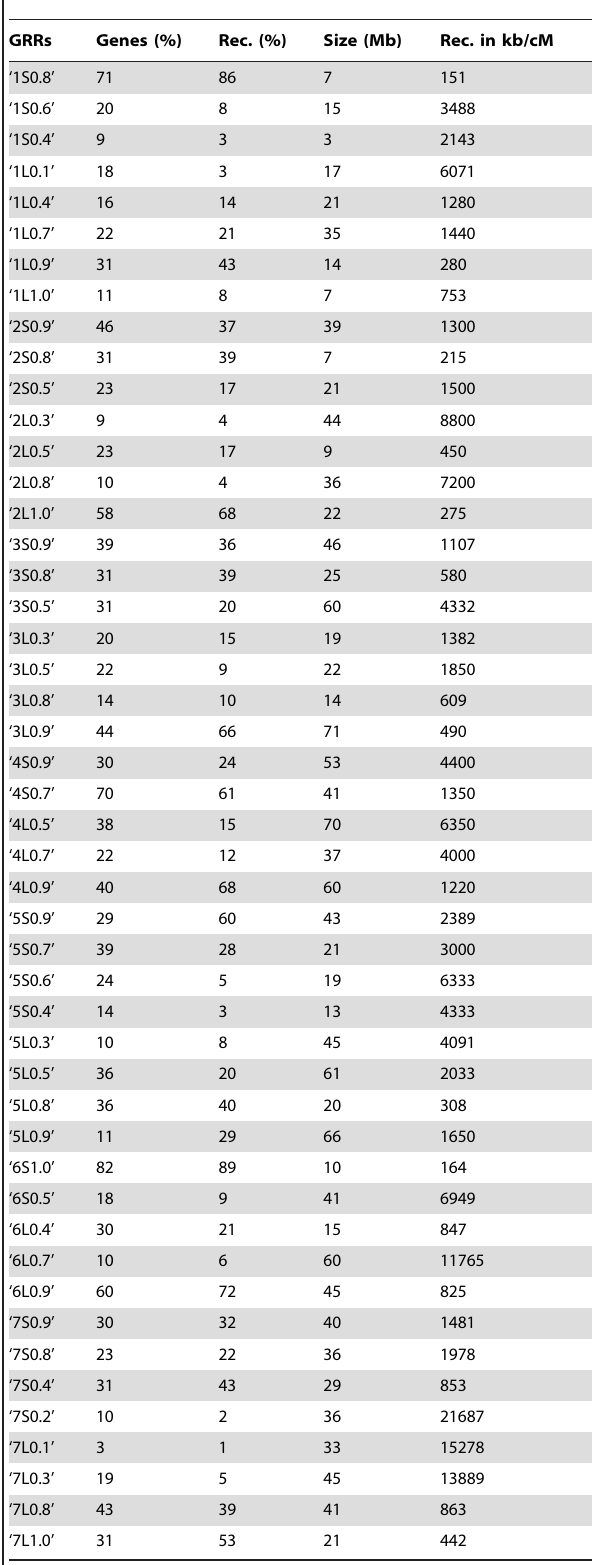
Table 4. Physical Locations of Genes/Markers, recombination (Rec.) in GRRs in Wheat